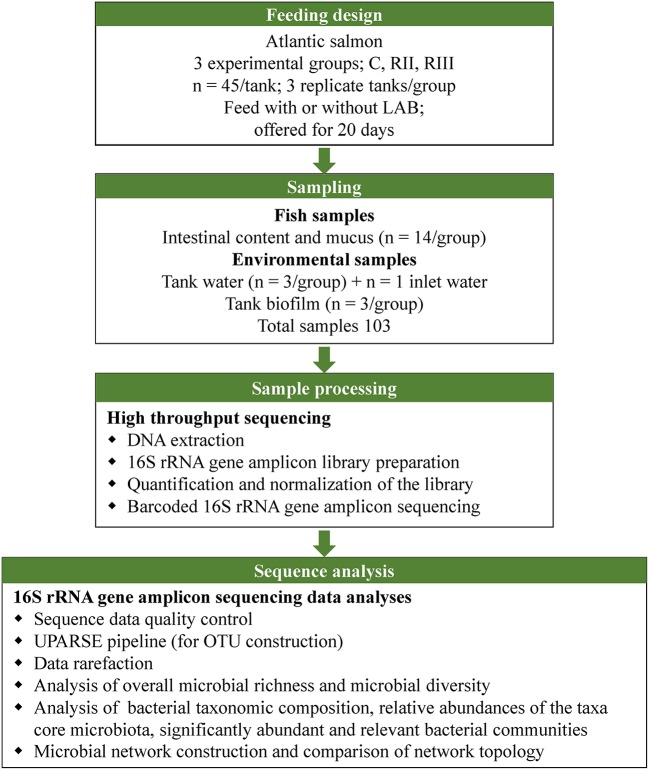
Illustration of the study design, sampling and sequence analyses.